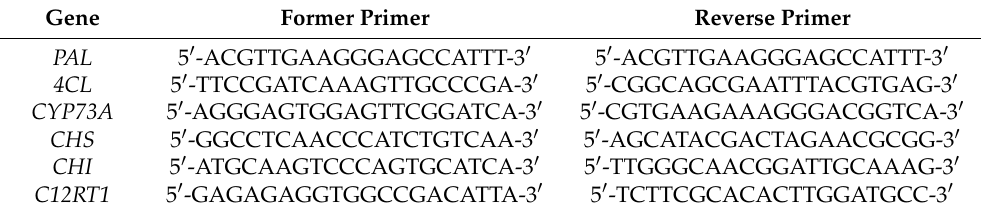
Table 1. The primer of six